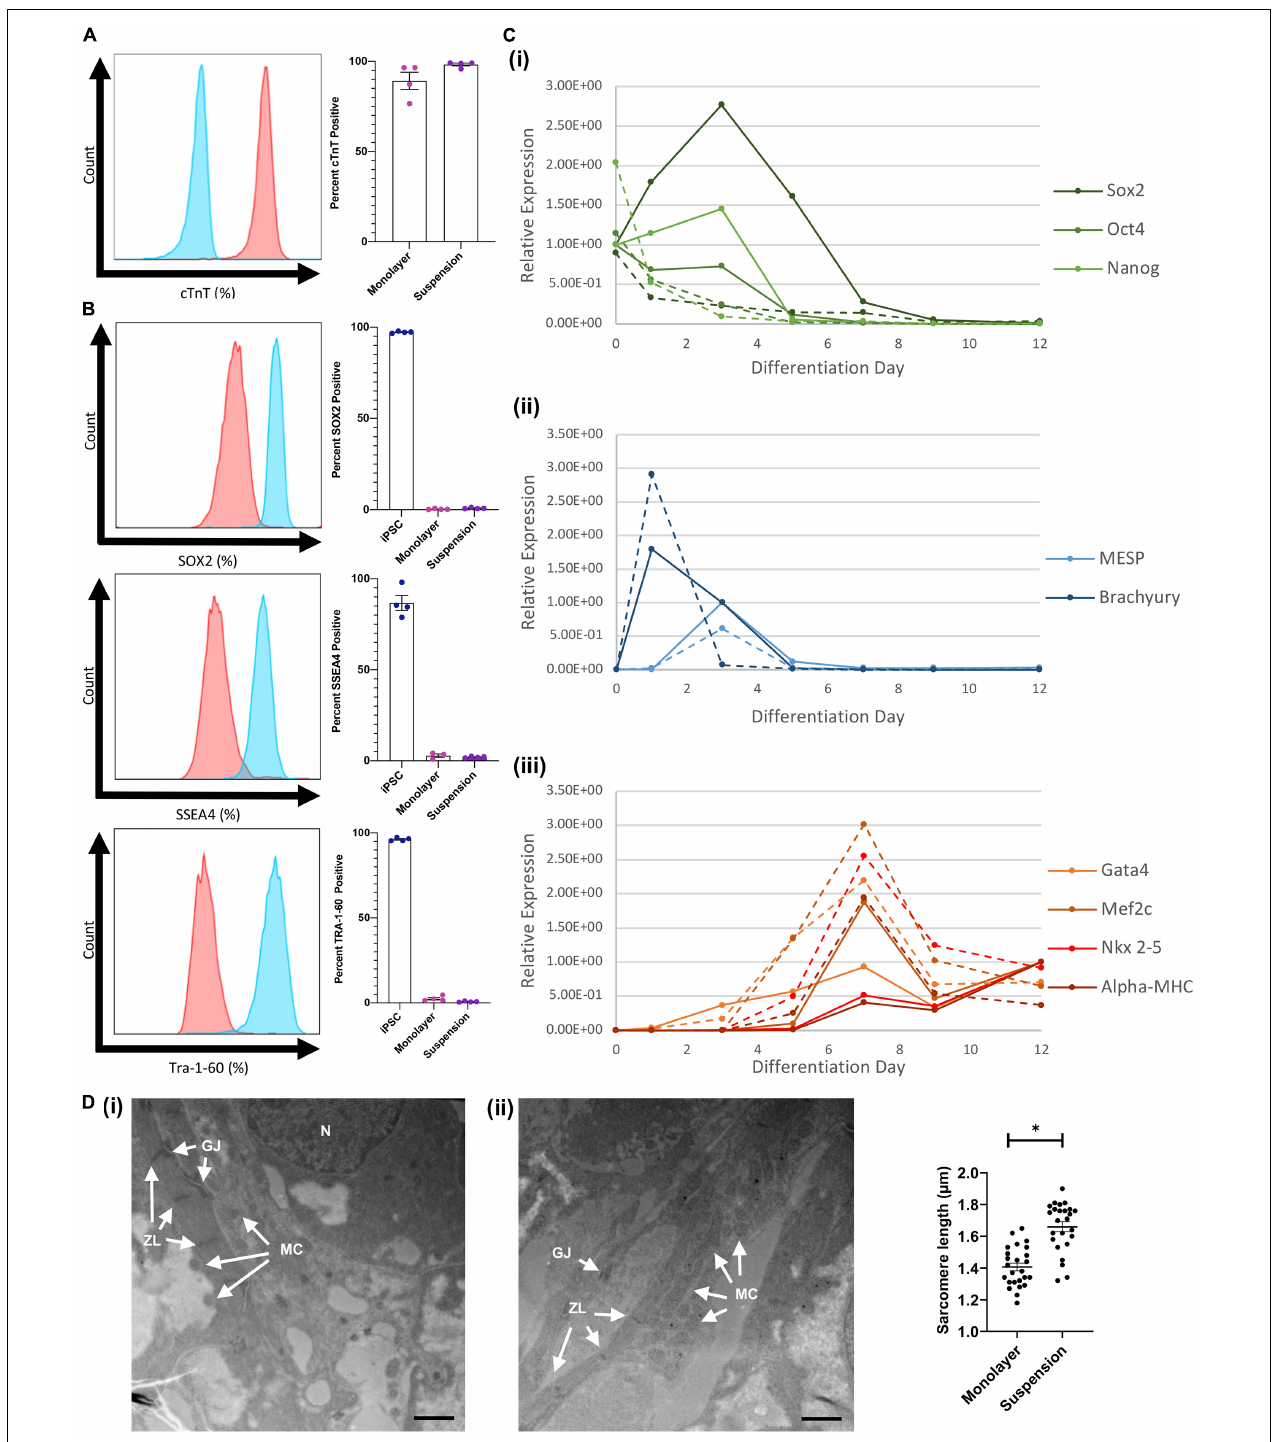
FIGURE 4 | Comparison of monolayer and suspension using the optimized protocol. (A) Flow cytometry staining for cTnT in suspension differentiated cardiomyoctes (red) compared with antibody isotype control (blue) with corresponding quantification. (B) Flow cytometry staining for iPSC markers (SOX2, SSEA4, and Tra-1–60) in monolayer and suspension (red) differentiated cardiomyoctes compared with iPSC (blue) positive control. (C) RT-qPCR analysis of (i) stem cell, (ii) mesoderm, and (iii) cardiac gene expression throughout differentiation for monolayer (solid) and suspension (dotted) techniques. (D) TEM images of (i) suspension and (ii) monolayer differentiated CMs with labeled characteristic features, N nucleus, GJ gap junction, ZL z-line, and MC mitochondria (Scale bar = 1 µ m). Measurements of mean sarcomere length in each condition ( n = 25). ∗ p < 0.0001.